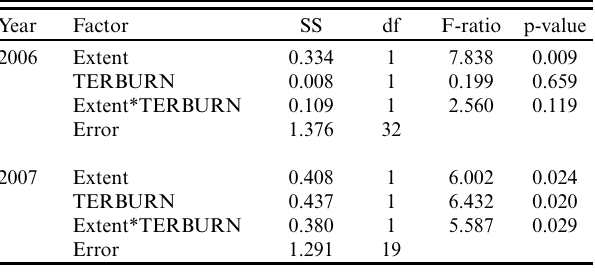
Table 5 . Analysis of variance comparing the log-transformed distances separating pre- and postburn centroids calculated for color-banded males (n = 59) monitored in 2006 and 2007. Centroids represent the average x , y coordinates for observations collected for marked Bachman’s Sparrows ( Peucaea aestivalis ) during each year of study. EXTENT distinguishes males associated with large-extent (70 - 100 ha burn blocks) or small- extent (< 15 ha) burn treatments. TERBURN (territory burned) distinguishes males that occupied home ranges where most (≥ 75%) ground cover was removed by fires versus males that occupied home ranges where most ground cover was not removed by fires (at least 75% retained).